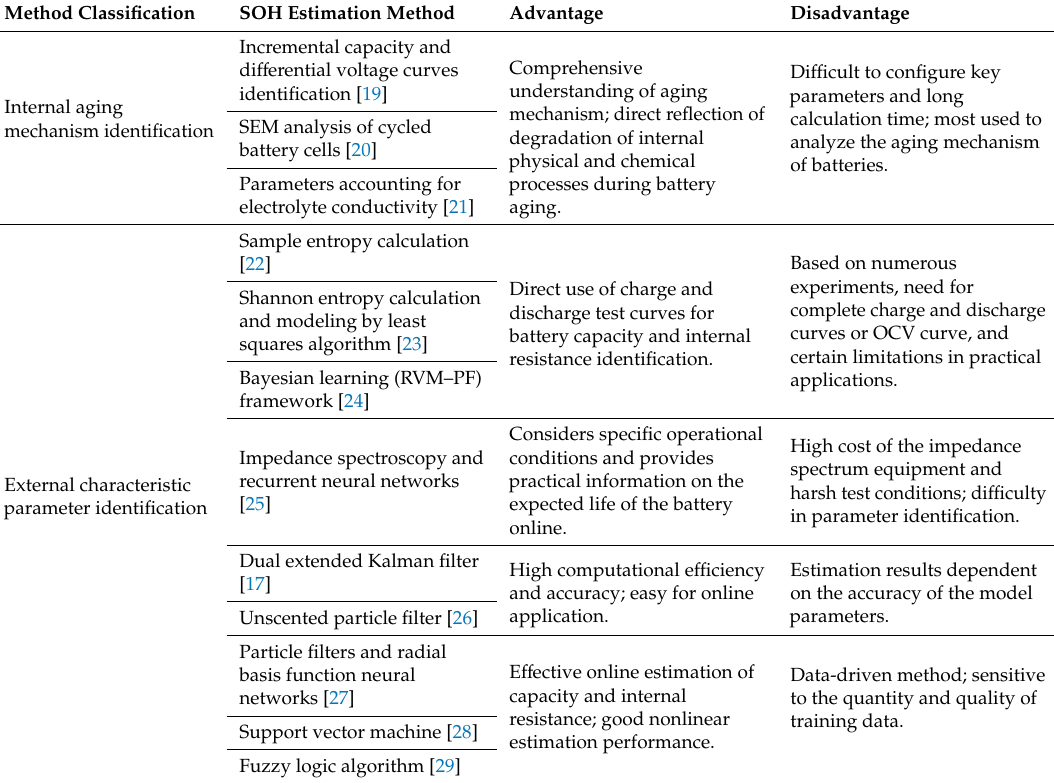
Table 2. Review of the state of health (SOH) estimation